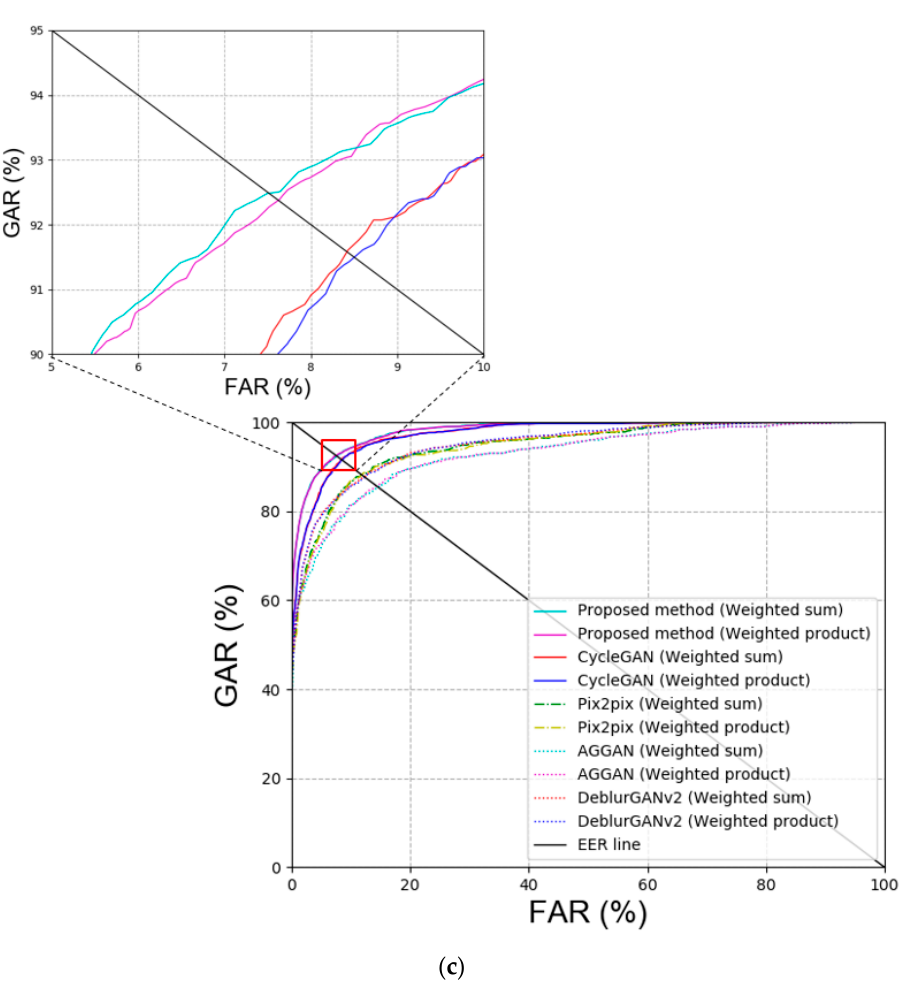
Figure 8. ROC curves via proposed and other GAN methods in DFB-DB2 ( a,b ) face and body image recognition results and ( c ) score-level fusion result.